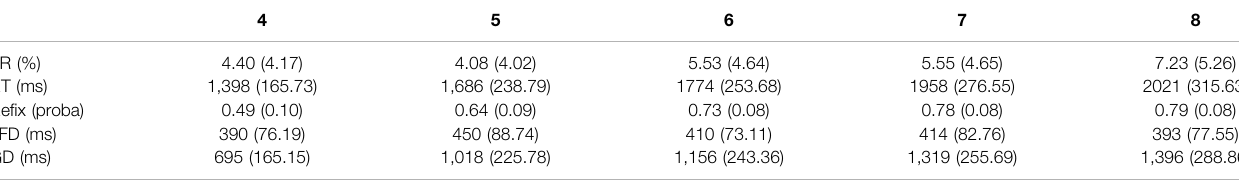
TABLE 1 | Average lexical decision response times and error rates, and averages of the three eye-tracking measures for each length (in number of letters) for words.